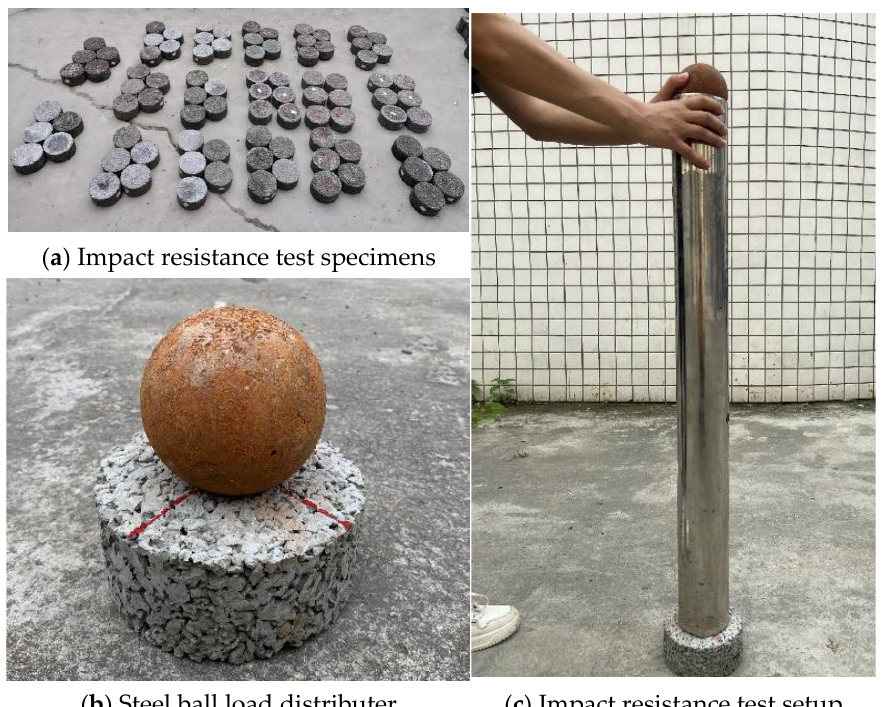
Figure 5. Impact resistance testing apparatus.